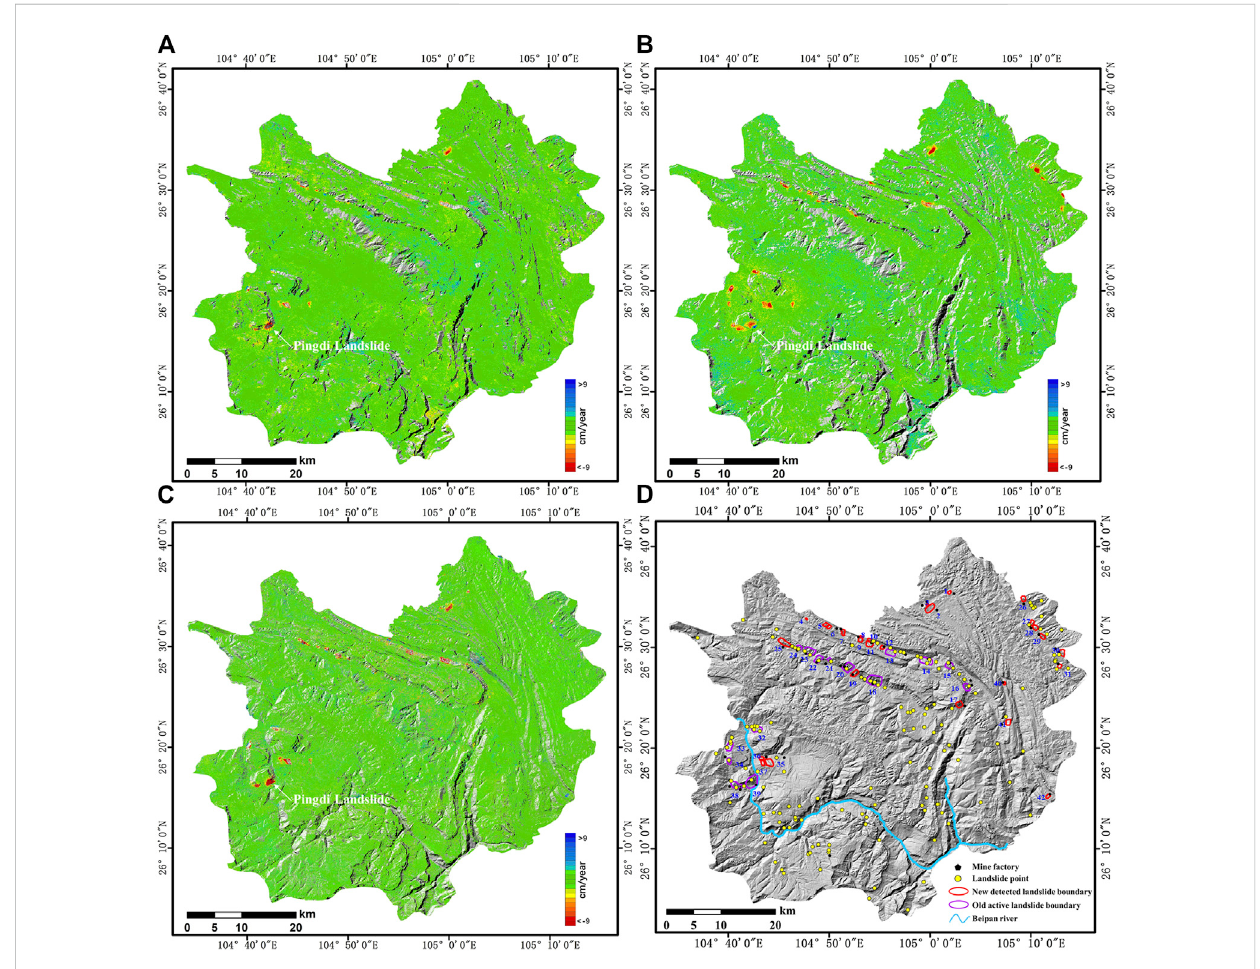
FIGURE 5 (A) InSAR deformation rate map with ascending Sentinel-1A images from January 2016 to February 2021; (B) InSAR deformation rate map with descending Sentinel-1A images from January 2016 to March 2021; (C) InSAR deformation rate map with ascending ALOS/PALSAR-2 images; (D) Landslides identi fi cation